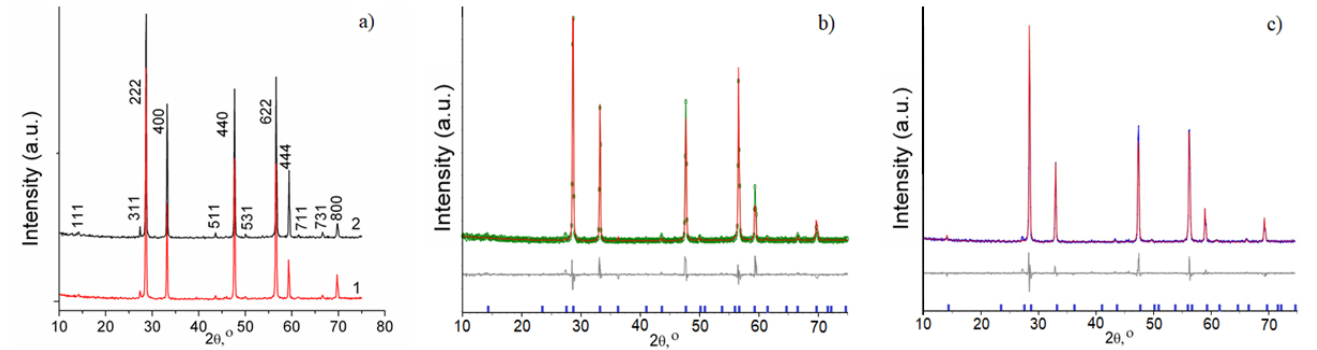
Figure 1. ( a ) X-ray diffraction patterns of (1) La 2 Hf 2 O 7 and (2) La 2 (Hf 1.9 La 0.1 )O 6.95 ; ( b ) Rietveld refinement of La 2 Hf 2 O 7 X-ray diffraction pattern: the experimental data (green dots), the calculated data (red line), and the difference between the experimental and calculated data (gray line); ( c ) Rietveld refinement of La 2 (Hf 1.9 La 0.1 )O 6.95 X-ray diffraction pattern: the experimental data (blue line), the calculated data (red line), and the difference between the experimental and calculated data (gray line).